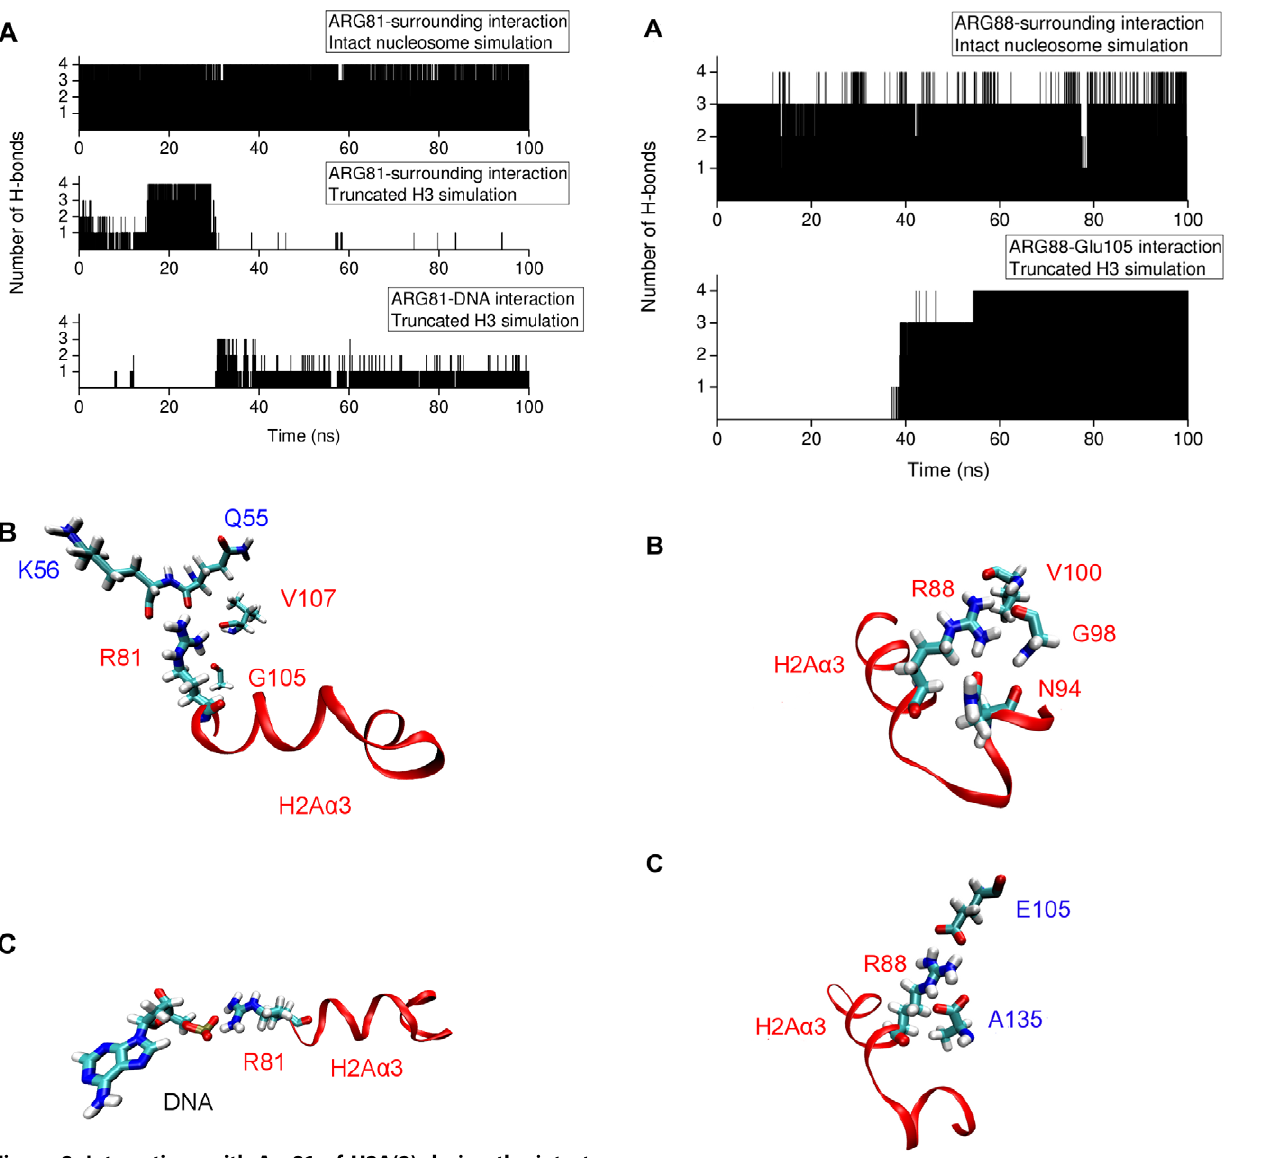
Figure 8. Interactions with Arg81 of H2A(2) during the intact and H3 tail-truncated simulations. (A) Number of H-bonds between Arg81 and selected surrounding residues from intact and H3 tail-truncated simulations. The selected surrounding residues are shown in (B) and (C). (B) Arg81 H-bonds with Gln55 and Lys56 of H3(1) and Gly105 and Val107 of H2A(2) during the intact nucleosome simulation. (C) Arg81 H-bonds with DNA in the H3 tail-truncated simulation. doi:10.1371/journal.pcbi.1002279.g008 mutations destabilize the contact of the C terminus with Ile51 and Gln55. Since the effects on nucleosome sliding and dimer exchange observed upon H3 tail truncation and Ile51 or Gln55 mutation are similar, H3 tail truncation may also involve destabilization of the interaction between the C terminal contact and Ile51 and/or Gln55. In Fig. 12B are plotted the distances between the centers of mass of Ile51 and Gln55 and the residues in close contact with them on the H2A C terminus for the simulations with truncated H3 tails. The plots indicate that Ile51 and Gln55 form stable contacts during the intact nucleosome simulation (black line) but undergo large positional fluctuations upon H3 tail truncation.